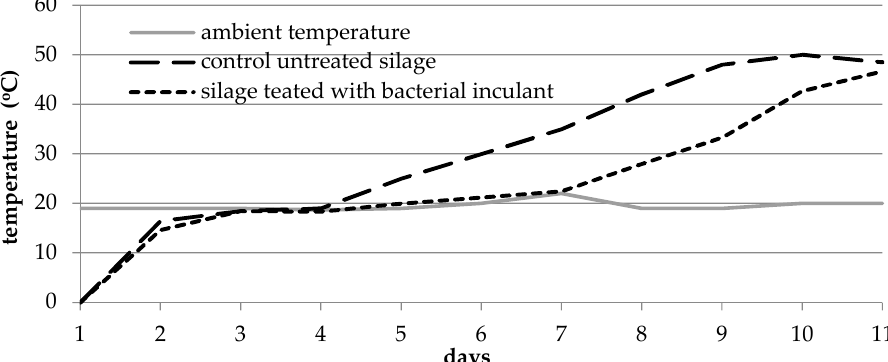
Figure 3. The effect of inoculant Biogas A consisted of L. buchneri KKP 2047p and L. diolivorans KKP 2057p on the aerobic stability test of grass silages.